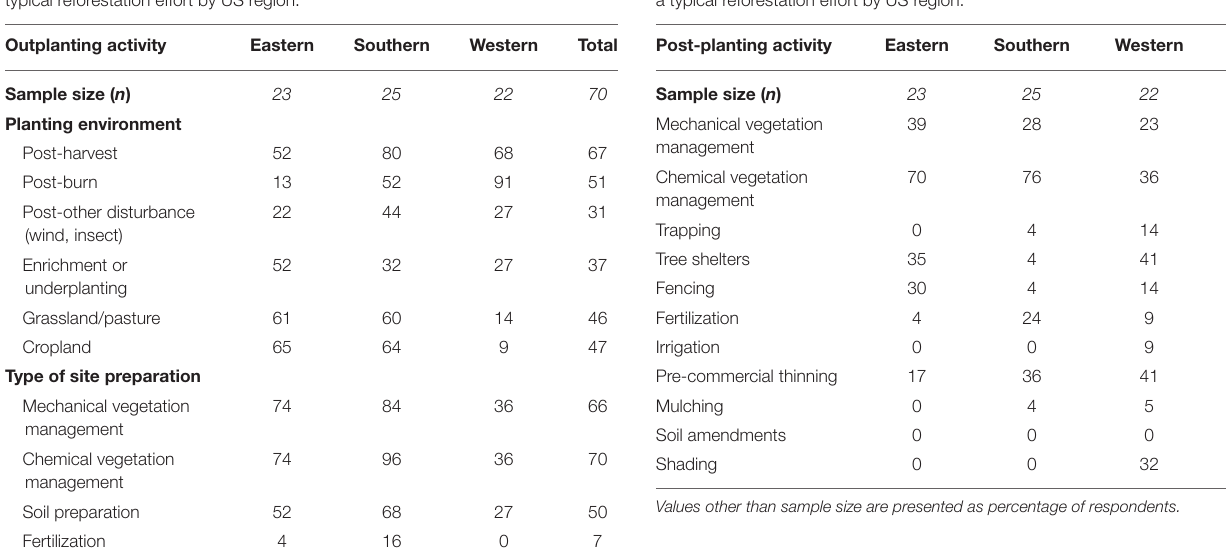
TABLE 2 | Percentage of foresters implementing various post-planting activities in a typical reforestation effort by US